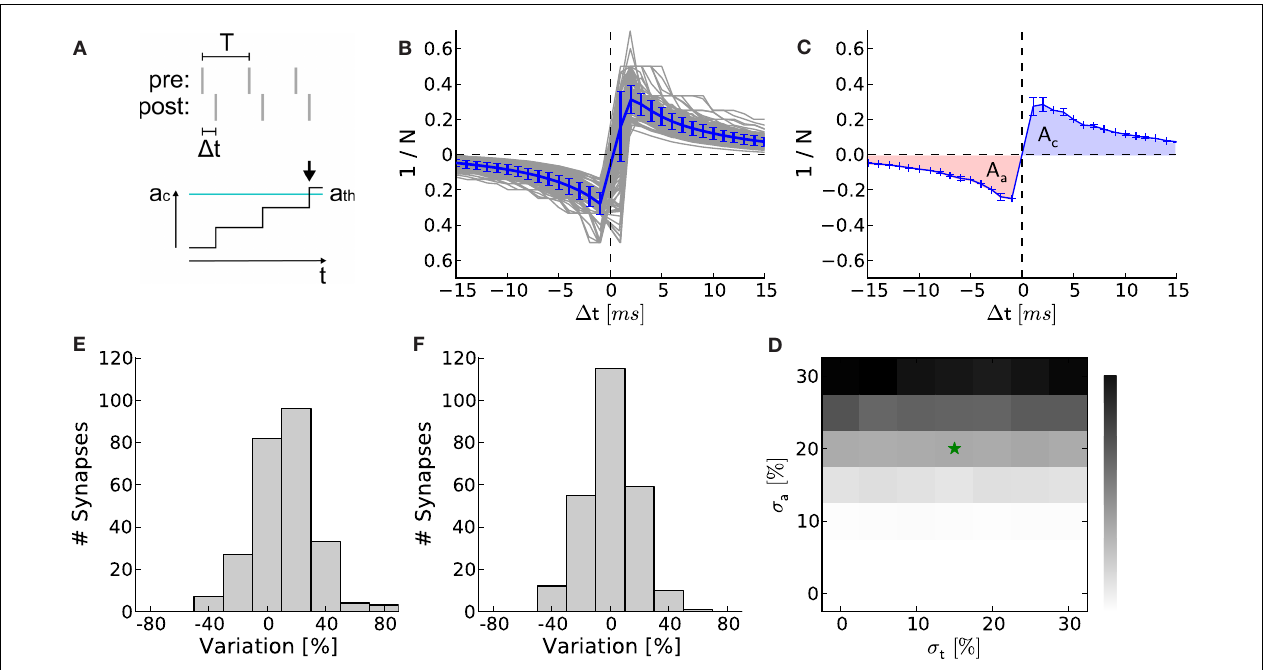
and their mean with error (blue). A speed-up factor of 10 5 is assumed.These curves correspond to x ( ∆ t ) in equation (1), whereas F ( w ) is realized by the LUT. (C) One arbitrarily chosen STDP curve (over 5 trials) showing the areas for ∆ t < 0 ( A a in red) and ∆ t > 0 ( A c in blue). (D) Asymmetry between A a and A c within synapses ( σ a = 21%). (E) Variation of the absolute areas between synapses ( σ a = 17%). (F) The p -value (as in Figures 7E–G ) in dependence on σ σ a and t .The values for (D,E) are marked with an